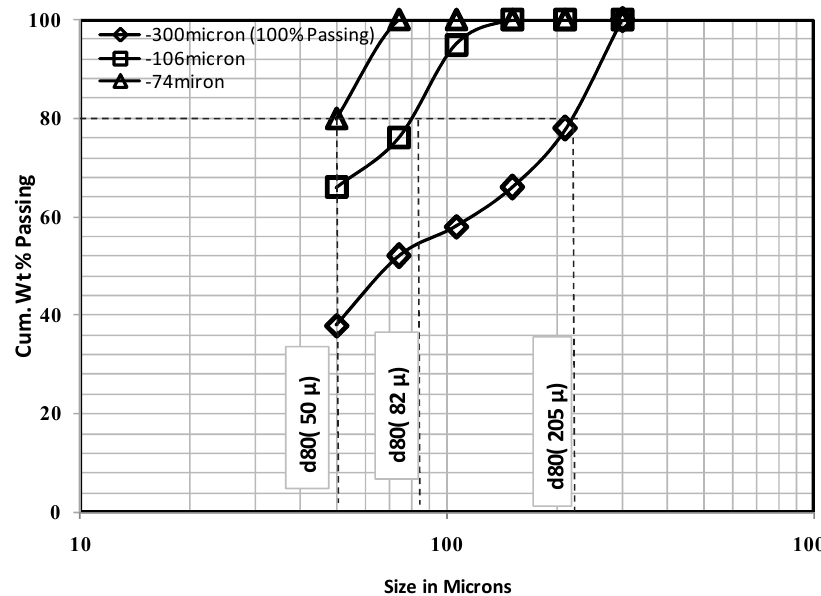
Figure 4. Particle size distribution of flotation feed at different MOG.